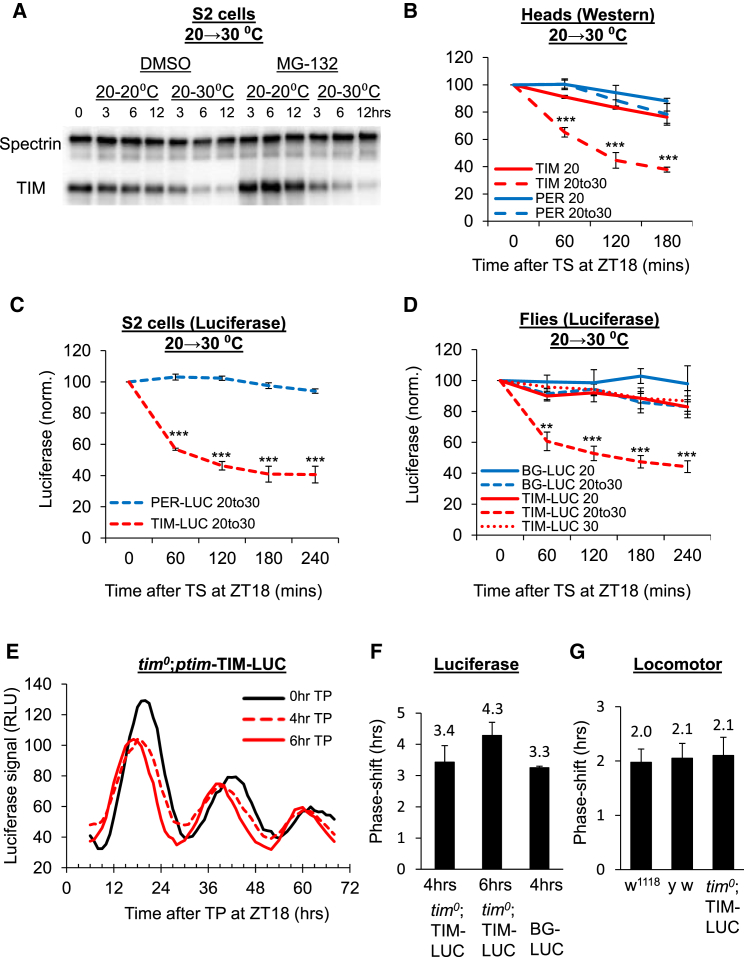
A Temperature Increase Degrades TIM and Resets the Drosophila Circadian Clock(A) A 20°C to 30°C temperature shift (TS) degrades TIM in Drosophila S2 cell culture. Western blots (WB) show TIM degradation even in the presence of MG-132. Spectrin is the loading control.(B) Quantification of WB from fly head extracts shows similar TIM (red), but not PER (blue), degradation induced by TS.(C and D) TS-induced TIM (red), but not PER (blue), degradation is reproduced using luciferase fusion proteins in S2 cells (C) and in whole flies (D). BG-LUC is an in vivo PER-luciferase fusion protein (Stanewsky et al., 1997).(E) Representative long-term luciferase recordings from TIM-LUC flies show that a 4-hr temperature pulse (TP) from 20°C to 30°C shifts the circadian clock in flies. Traces show a 6-hr moving average of TIM-LUC rhythms in flies.(F and G) Quantification of phase advances induced by a 4-hr TP at ZT18 in peripheral (TIM-LUC) (F) and brain (locomotor behavior) clocks (G). Error bars represent SEM for (B)–(D) or SD for (F) and (G). p < 0.01 or p < 0.001 from at least five independent experiments (n ≥ 6 each) is indicated with “∗∗” or “∗∗∗,” respectively.See also Figure S1.